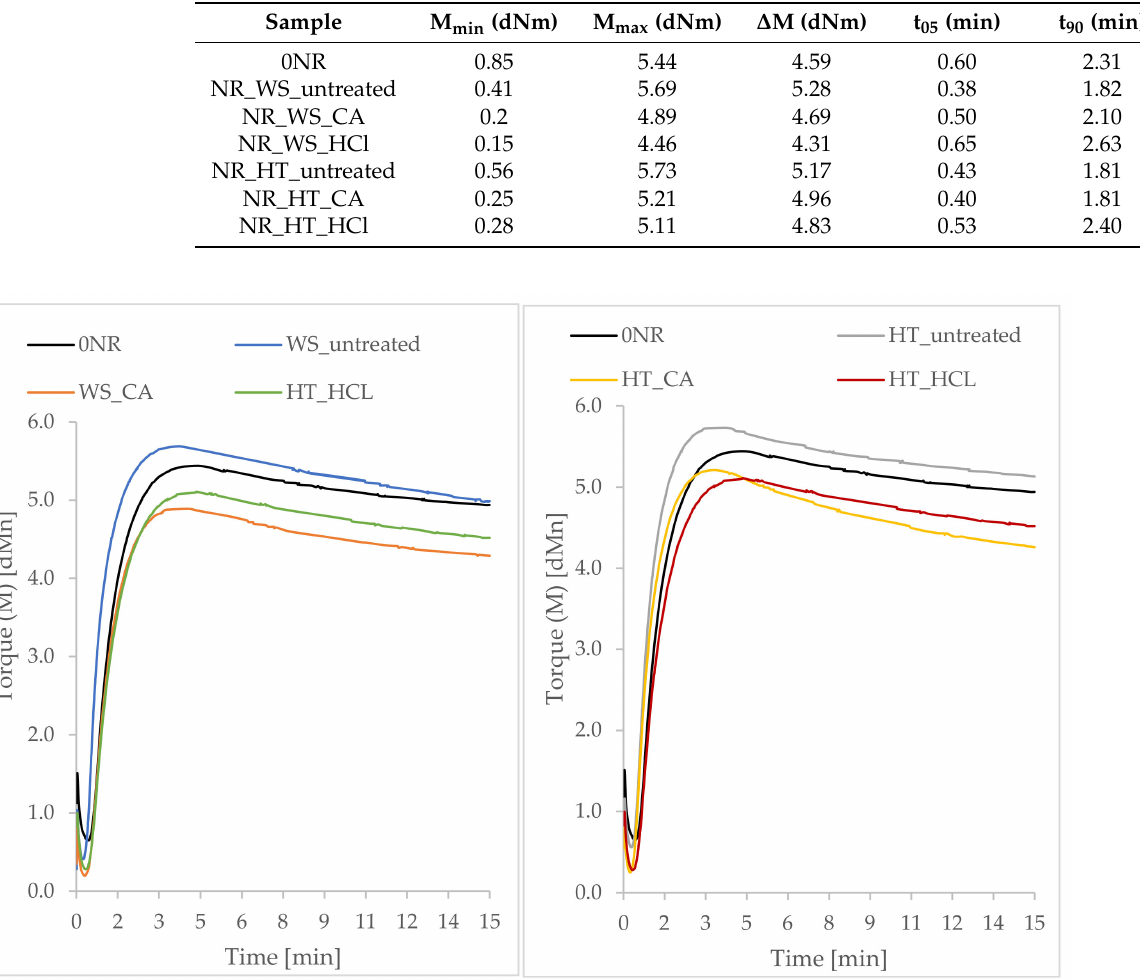
Table 4. Rheometric characteristic of rubber mixtures.